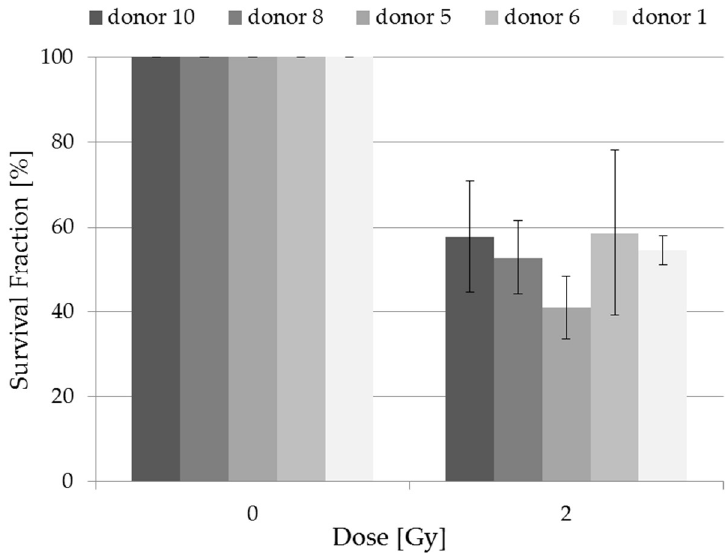
Figure A3. Donor-specific differences in the survival fraction of irradiated adipose-derived stem cells. The cells were seeded 24 h before the IR procedure and stained 20 days later by crystal violet to visualize formed colonies. The cell survival fractions (SF) of the different experimental approaches were normalized to those of unirradiated cells; n = 3 presented as mean ± standard deviation (one sample t -test).